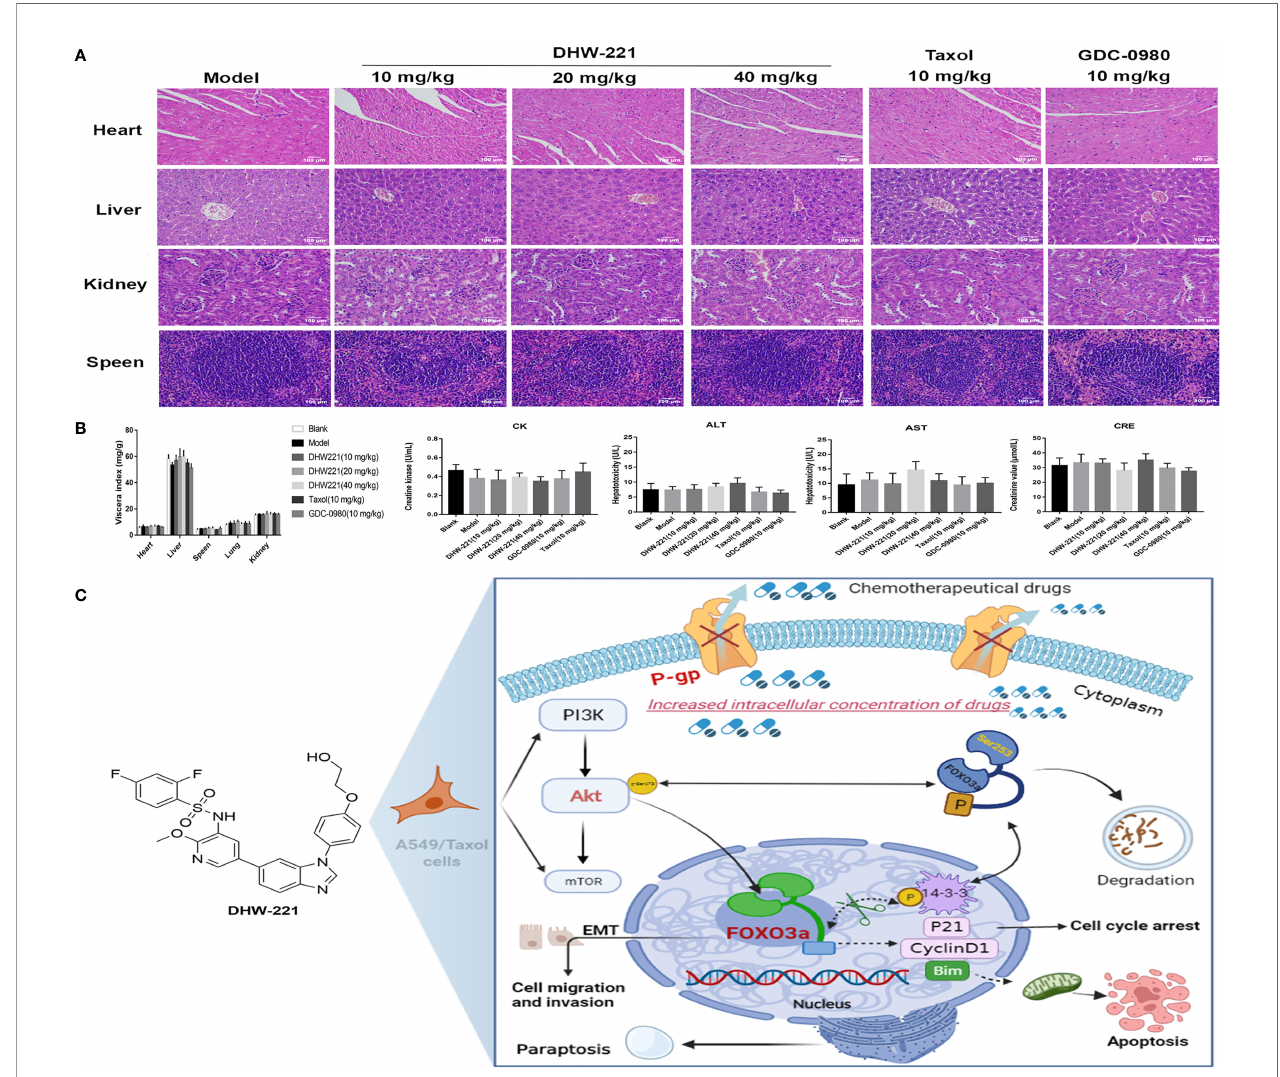
FIGURE 8 | DHW-221 has no obvious toxicity in DHW-221-administered nude mice. (A) HE staining of the heart, liver, kidney, and speen from orthotopic nude mice. Scale bar = 100 µm. (B) The viscera index of organs (heart, liver, speen, lung, and kidney) and the biochemical parameters of heart (CK), liver (ALT, AST), and kidney (CRE) from the serum of each group in orthotopic nude mice. Data were presented as mean ± SD. Statistical comparisons were carried out with one-way ANOVA followed by Dunnett ’ s post-hoc test for multiple comparisons (n = 6). (C) Molecular mechanism underlying the anticancer effects of DHW-221 on the P-gp and PI3K/Akt/FOXO3a signaling pathway in A549/Taxol